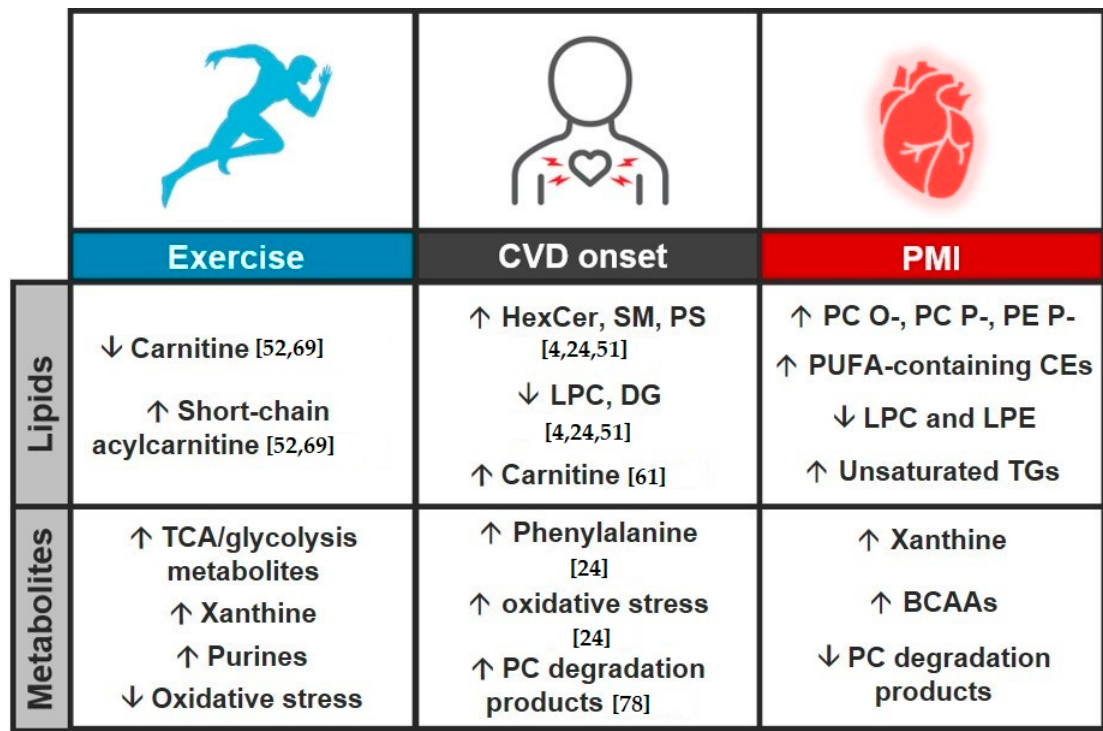
Figure 6. Comparison of lipidomic and metabolomic trends for exercise ( left ), cardiovascular disease (CVD) onset ( middle ) and planned myocardial infarction (PMI) model ( right ). Results include a summary of observed results from this and the referenced previous studies noted by citation number in the figure [4,24,51,52,61,69,78].